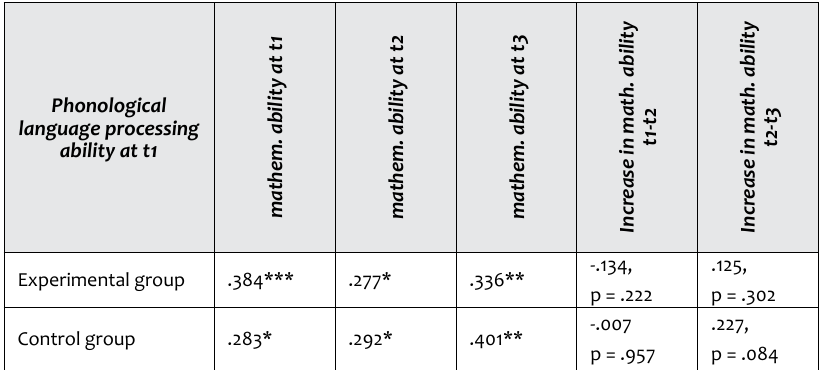
Table 1: Influence of the phonological language processing at t1 on the increase in mathematical ability (WLE).